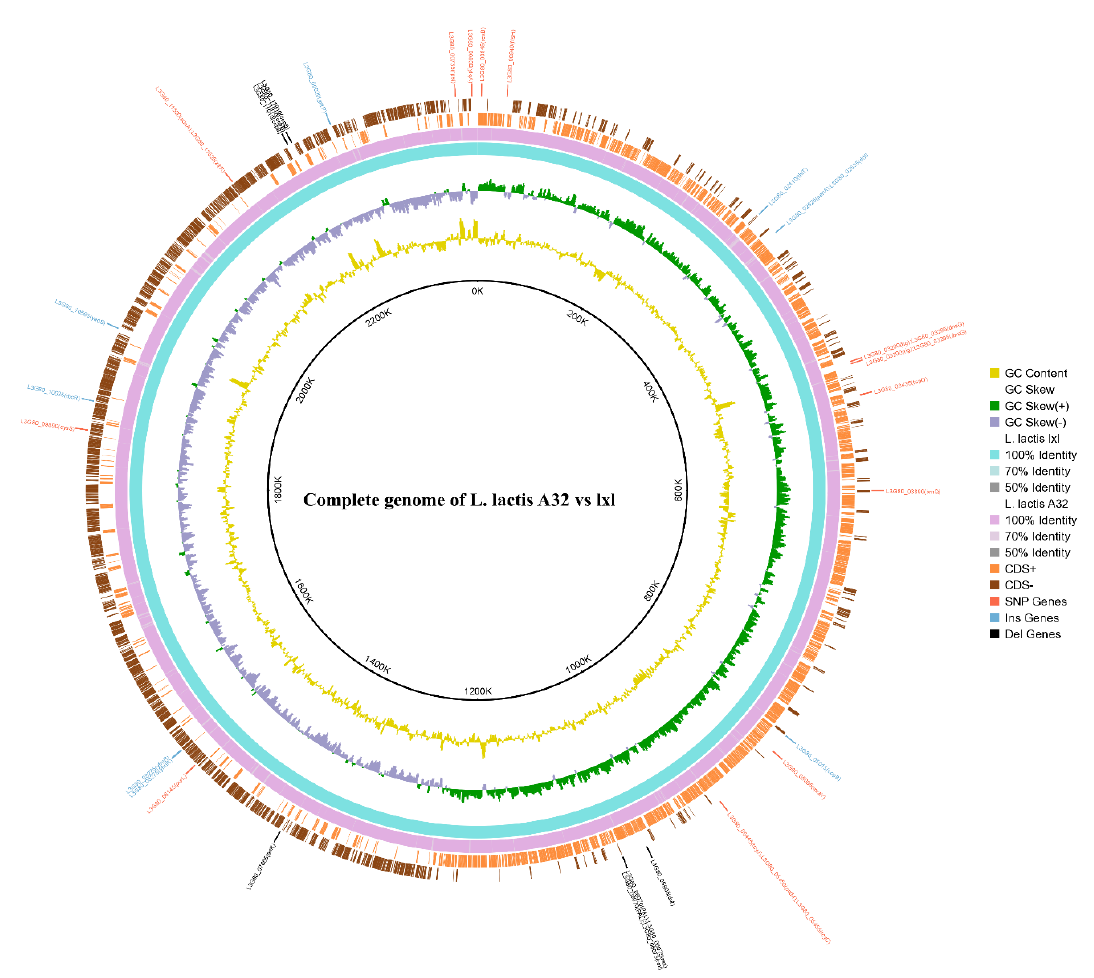
Figure 3. The cyclic images from the genome comparison. Table 3. COG analysis and type of gene mutation.